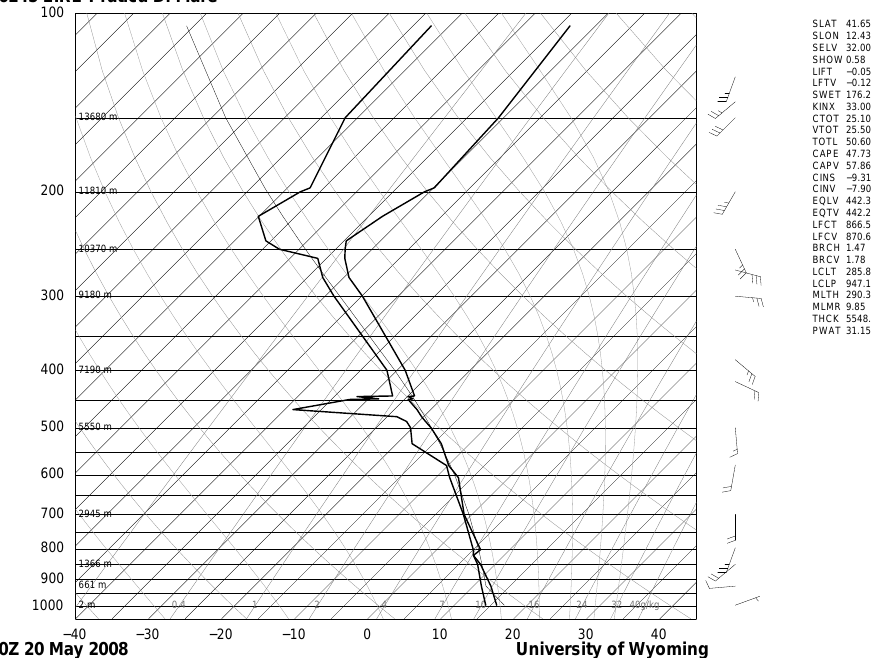
Figure 5. PDM sounding at 00:00UTC, 20 May